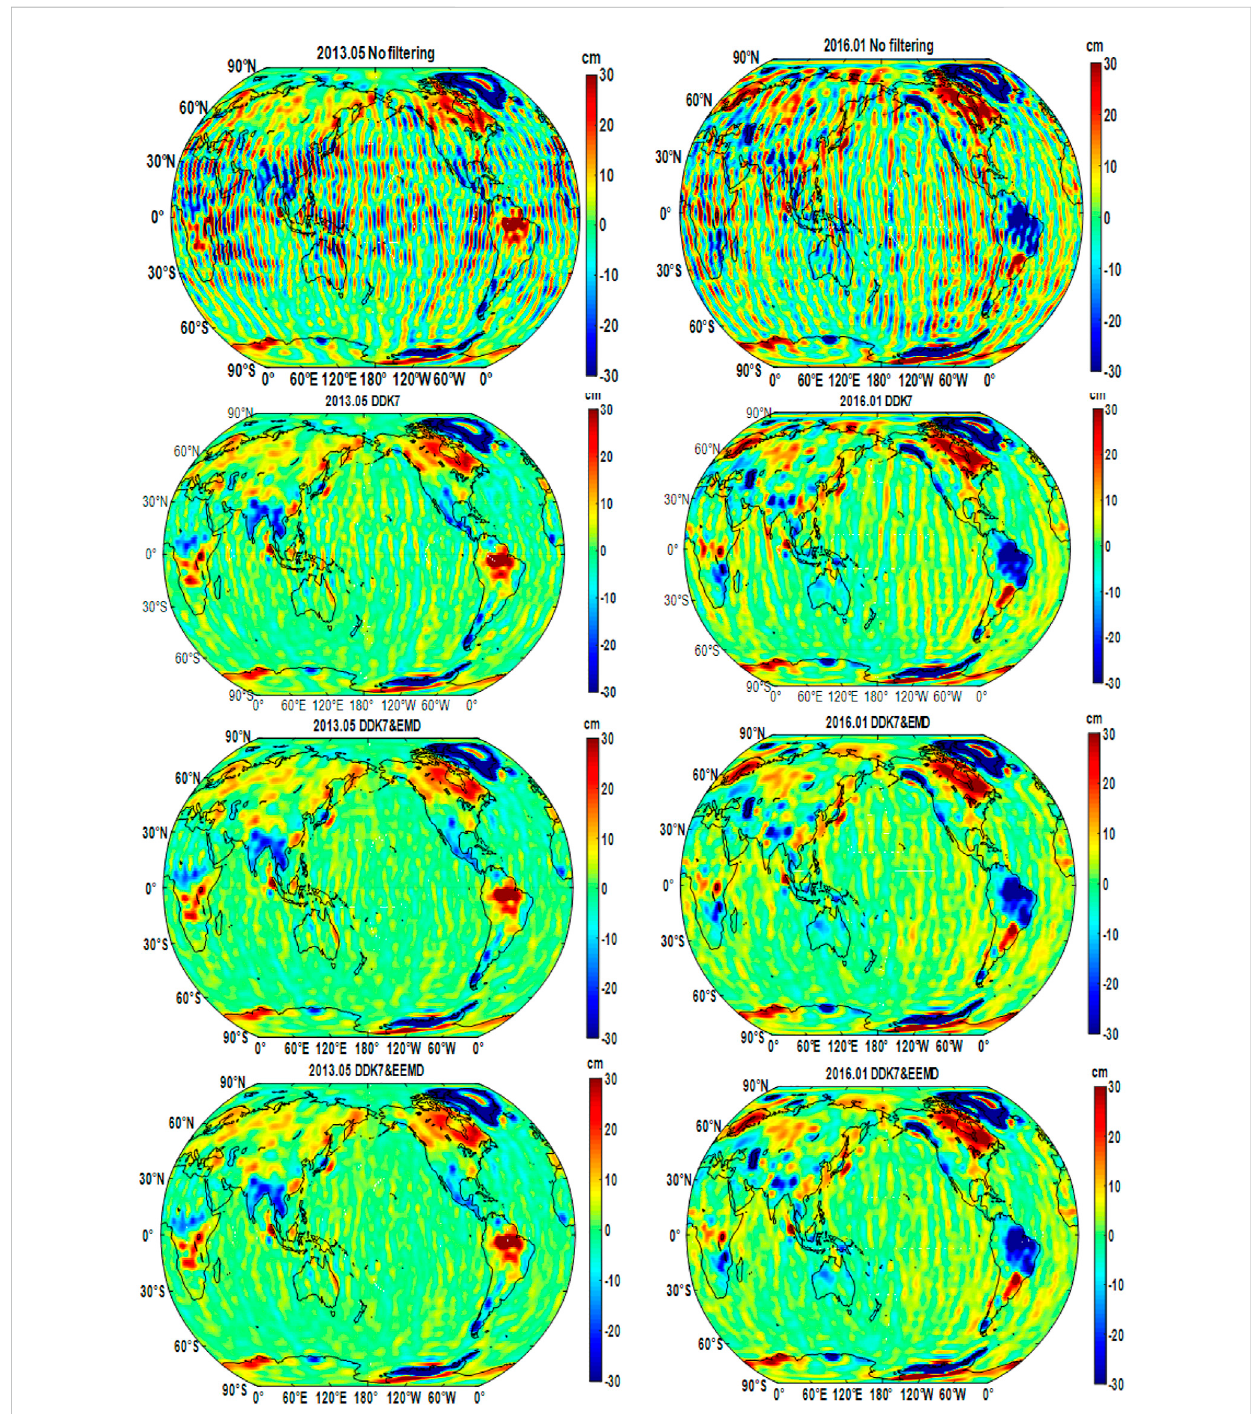
FIGURE 7 Global mass changes in May 2013 and January 2016 (Row 1: No fi ltering; Row 2: DDK7; Row 3: EMD; Row 4: EEMD).